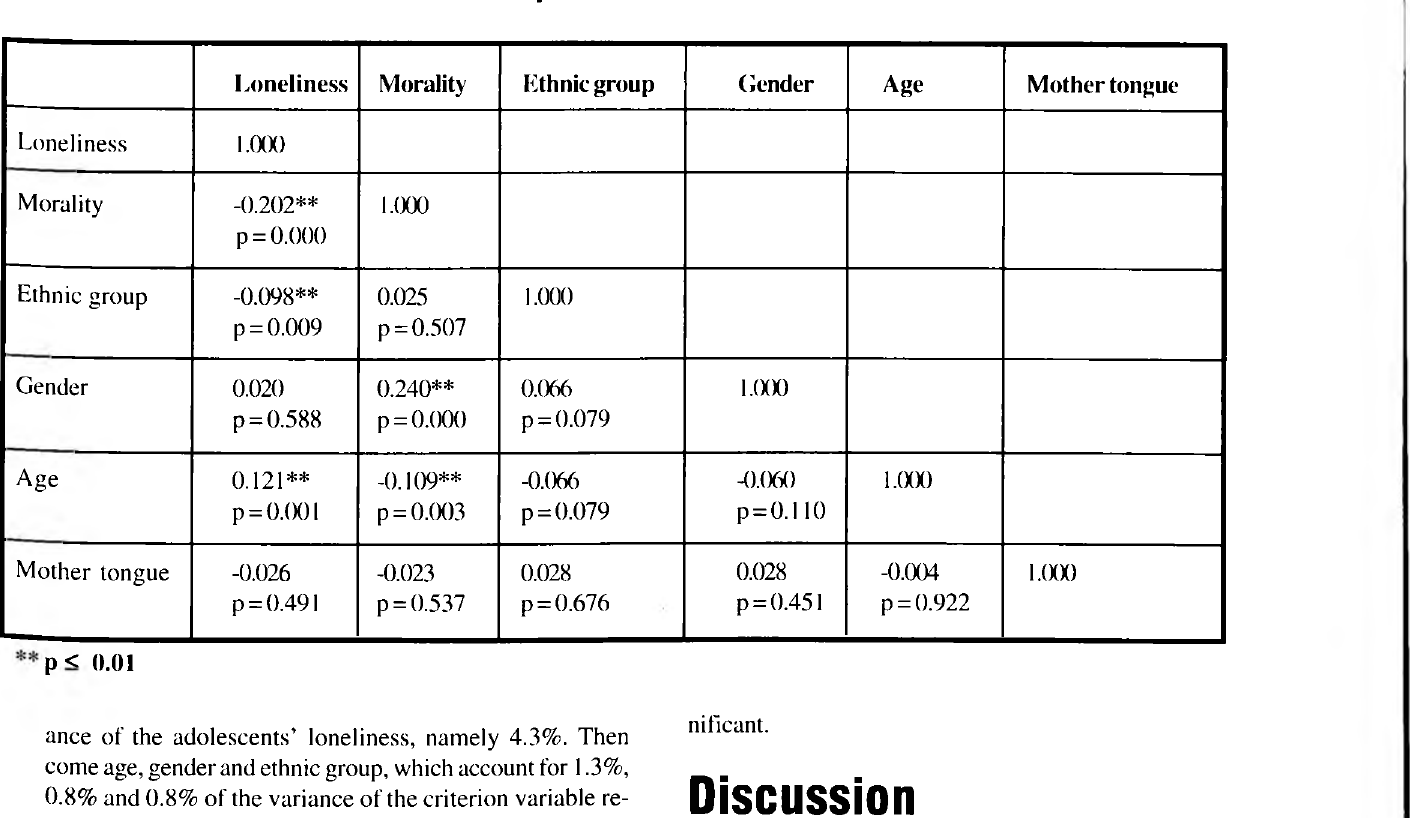
Table 5: Inter-correlation matrix of all the predictor variables